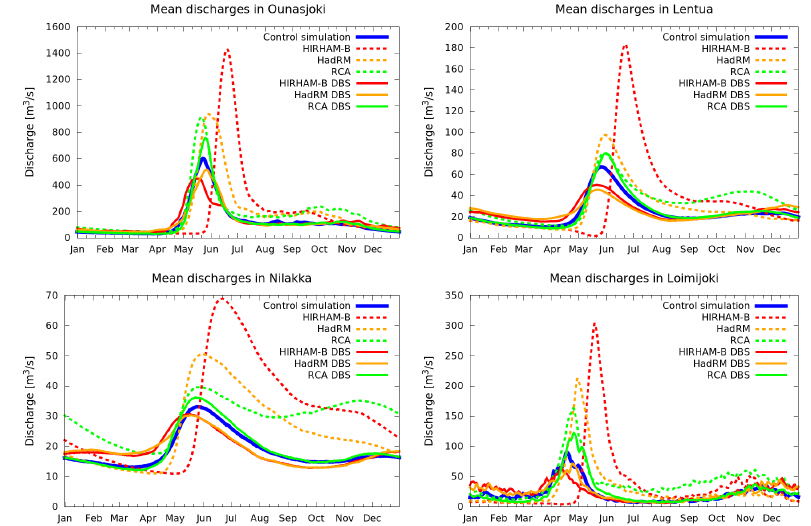
Figure 11. Hydrographs of simulated daily mean discharges in 1961–2000 with uncorrected RCM outputs (dashed lines) and corrected temperatures ( T Gaussian) and precipitation ( P double gamma) (solid lines) compared to control simulation discharges (blue line).